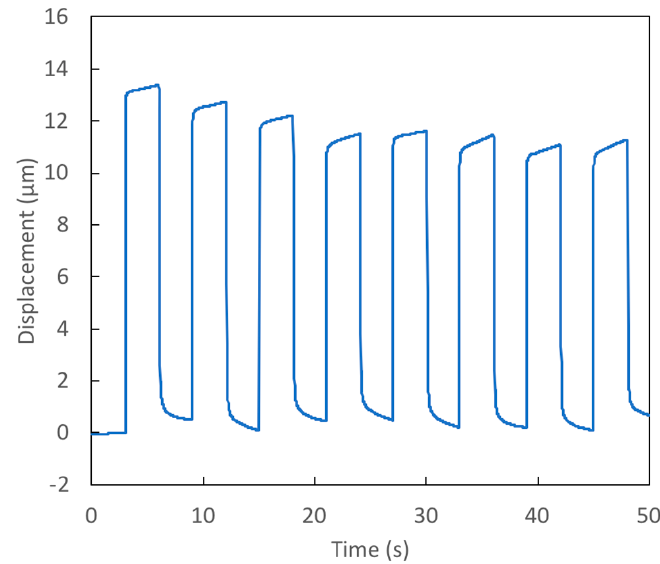
Figure 7. Test 5—Response of prototype with a thin (40 µ m), small diameter (441 µ m) membrane to 14 V square wave voltage signal.